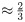
Histogram of the slopes of regression lines for the highly correlated with growth proteins (473 and 305 proteins in the left and right panels respectively).Ribosomal proteins are stacked in green on top of the non ribosomal proteins, marked in blue. Proteins fractions were normalized to account for differences in slopes resulting from differing average fractions (Methods). The expected distribution of slopes given the individual deviations of every protein from a linear regression line, assuming all proteins are coordinated, is plotted in gray. Dashed vertical lines at 0.5 and 2 represent the range at which the slopes of ≈23 of the proteins lie. Left panel—data from [29], right panel—data from [13]. High correlation proteins share similar normalized slopes, implying they are coordinated, maintaining their relative ratios across conditions (see text for further details). Ribosomal proteins, shown in green, scale with growth rate in a manner similar to the rest of the high correlation proteins (see text and S7 Fig).